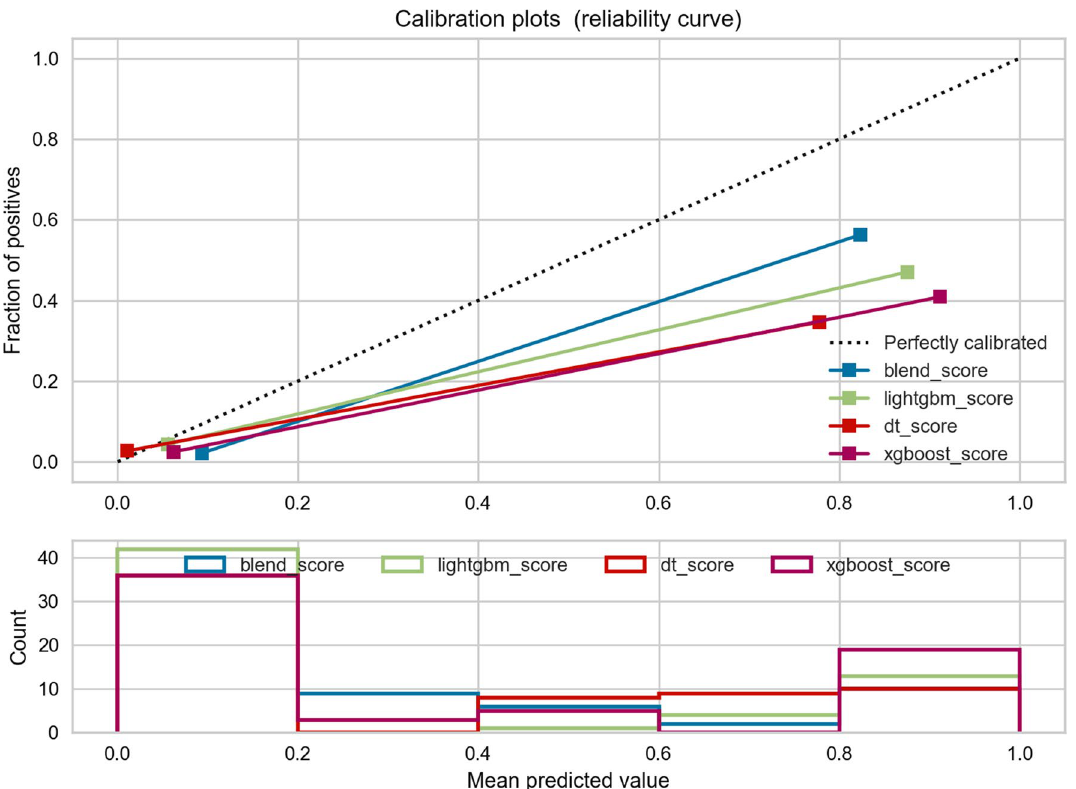
Fig. 5 Calibration curve in external validation dataset. The black dashed line represents the ideal prediction curve. As the prediction curve of machine learning model approaches the dashed line, the model becomes more accurate. The average distributions of each probability in four models are displayed in the bar chart below